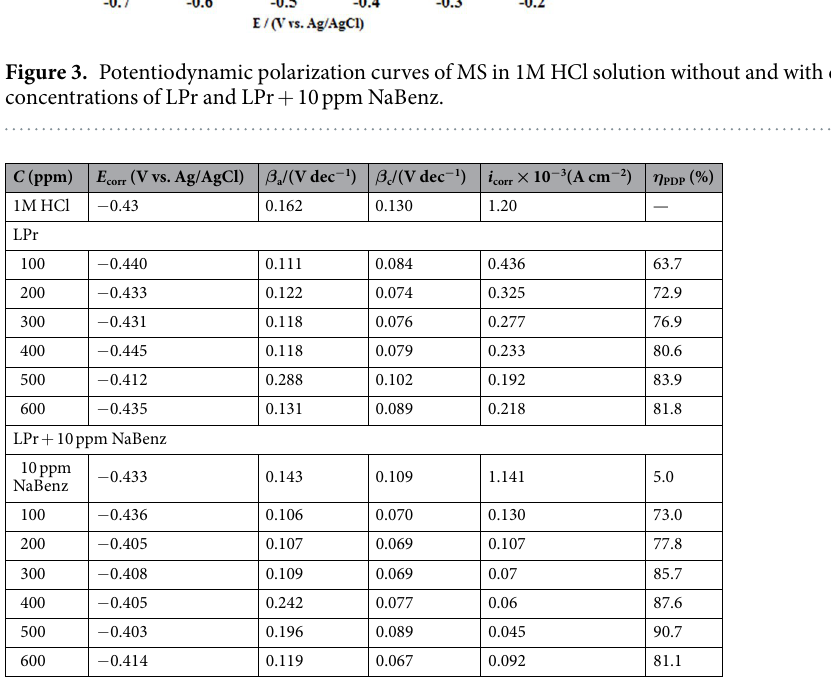
Table 1. PDP Parameters for MS in 1M HCl in the absence and presence of different concentrations of LPr and LPr + 10 ppm NaBenz at 30